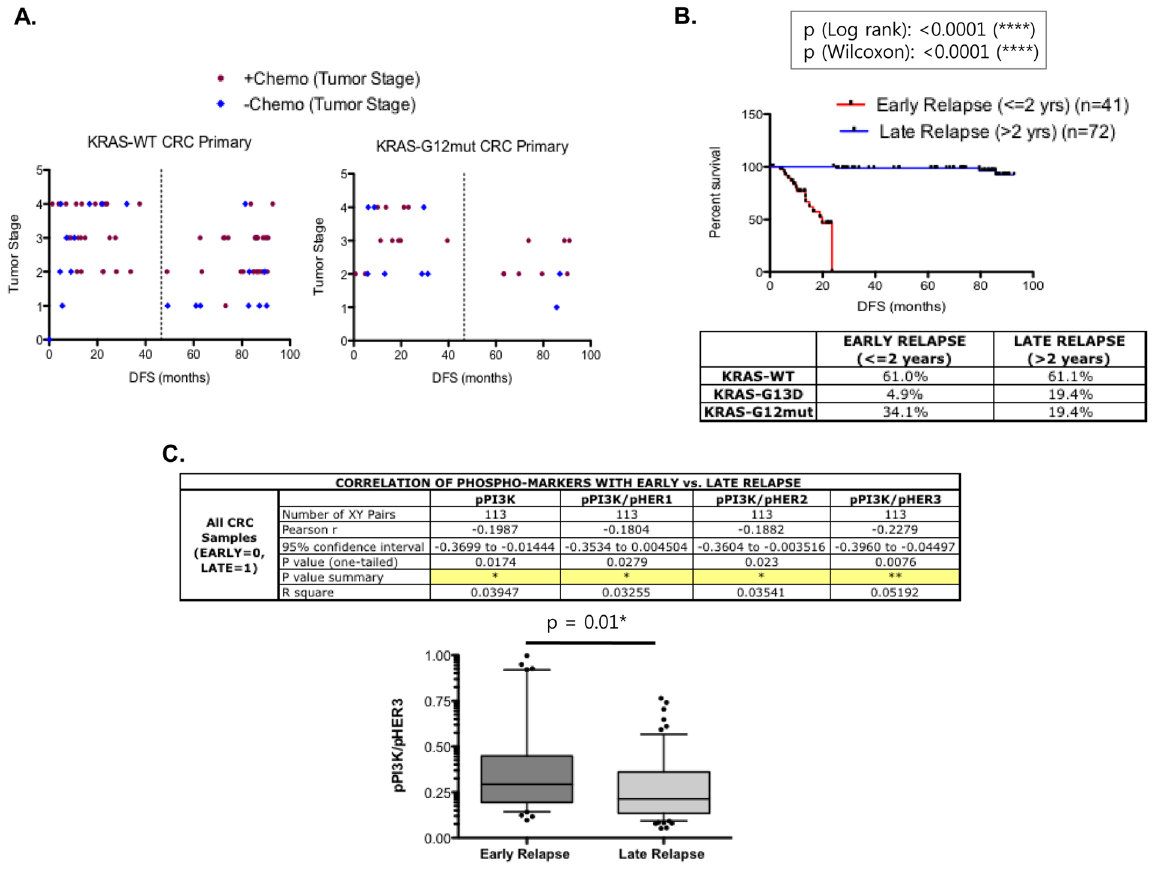
Figure 1. Heterogeneity in colorectal cancers (CRCs). (A) Plot of disease-free survival (DFS) versus tumor stage in KRAS WT and G12mut primary CRCs. Each dot represents an individual patient and the brown and blue dots indicate patients that did or did not receive adjuvant chemotherapy, respectively. (B) Comparative DFS curves of CRC samples segregated by their recurrence times post-surgery. DFS for early relapse patients (recurrence # 2 years) is shown in red and DFS for late relapse patients (recurrence . 2 years) is shown in blue. p-Values are indicated. The table below the graph lists the percentage of patients with a specific KRAS genotype in each group. (C) Pearson correlation analysis of early vs. late relapse CRCs to the expression of pPI3K, pPI3K/pHER1, pPI3K/pHER2, and pPI3K/pHER3 in the entire CRC cohort. Significant correlations are highlighted in yellow. The plot in the box shows the difference in the pPI3K/pHER3 ratios in early relapse vs. late relapse CRCs.